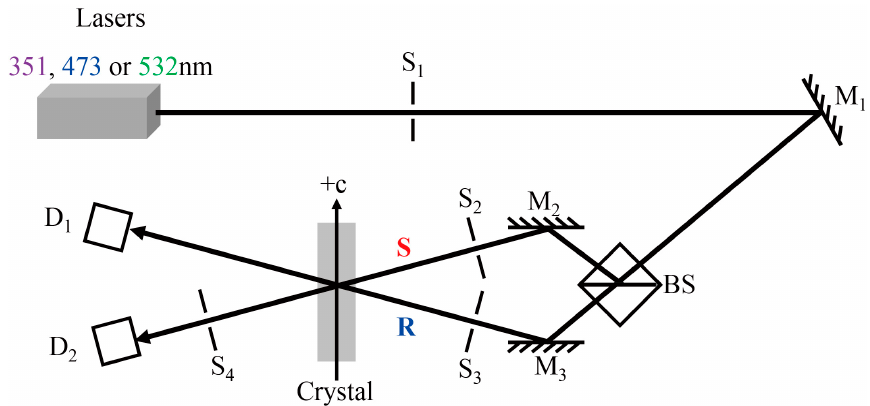
Figure 1. Schematic diagram of the configuration for holographic experiment: M 1 –M 3 , mirrors; BS, beam splitter; S 1 –S 4 , shutters; D 1 –D 2 , detectors.